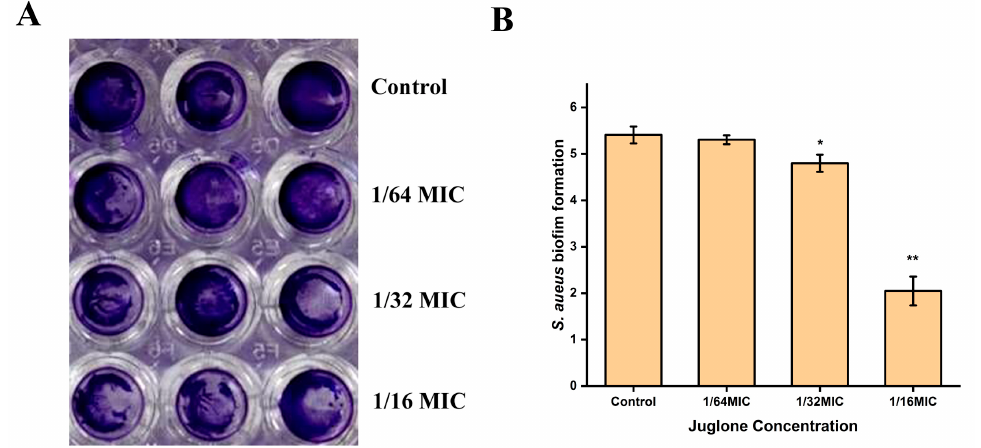
Figure 5. The effect of juglone on S. aureus biofilm formation. ( A ) After treatment of S. aureus with sub-inhibitory concentration of juglone for 24 h, the formation of biofilm was observed by crystal violet staining. ( B ) Statistical analysis of the effects of sub-inhibitory concentrations of juglone on S. aureus biofilm formation. MIC is 1000 µ g/mL. When p < 0.01, it is represented by **, when p < 0.05, it is represented by **.